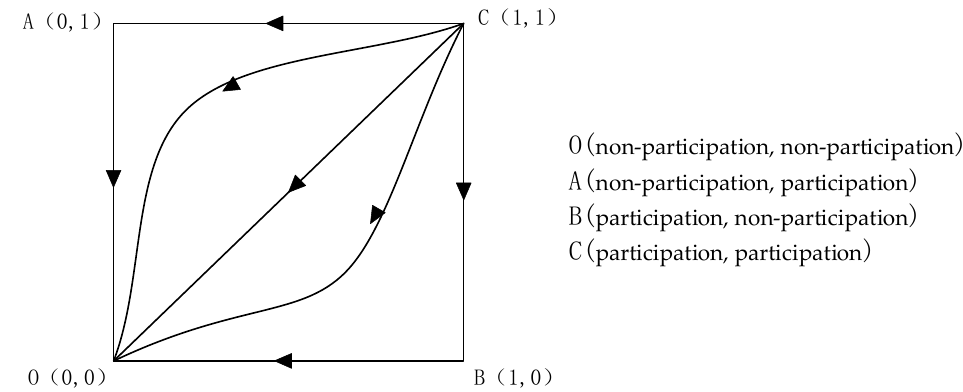
Figure 1. Evolutionary phase diagram when the expected benefit to one of the residents and the government is less than the cost to them.